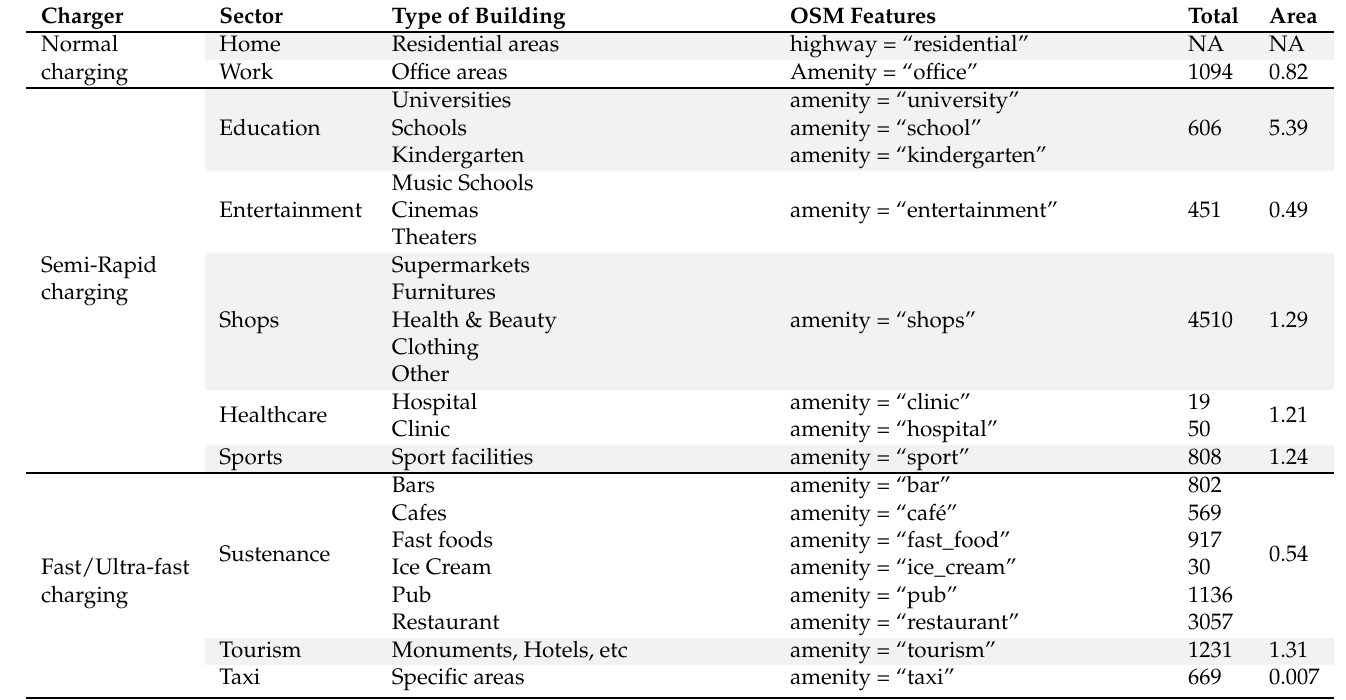
(convenience stores, supermarkets, shopping malls), to hospitals. Table 3. This table summarizes the different amenities used in the study. The ‘Charger’ column shows which charging technology was assigned, among normal, semi-rapid, and fast charging. Amenities are grouped into different sectors named in the ‘Sector’ column. The ‘Type of Building’ column indicates which POI is discussed. The ‘OSM Features’ column denotes the specific tag used on OSM to extract the data. The ‘Total’ column gives the number of POI extracted while the ‘Area’ indicates the sum of their areas in km 2